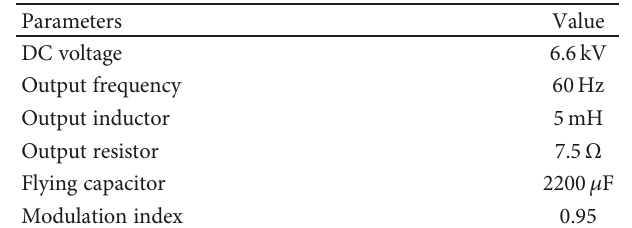
Figure 5: The controller diagram of the four-level NNPC inverter. Table 6: Simulation parameters.